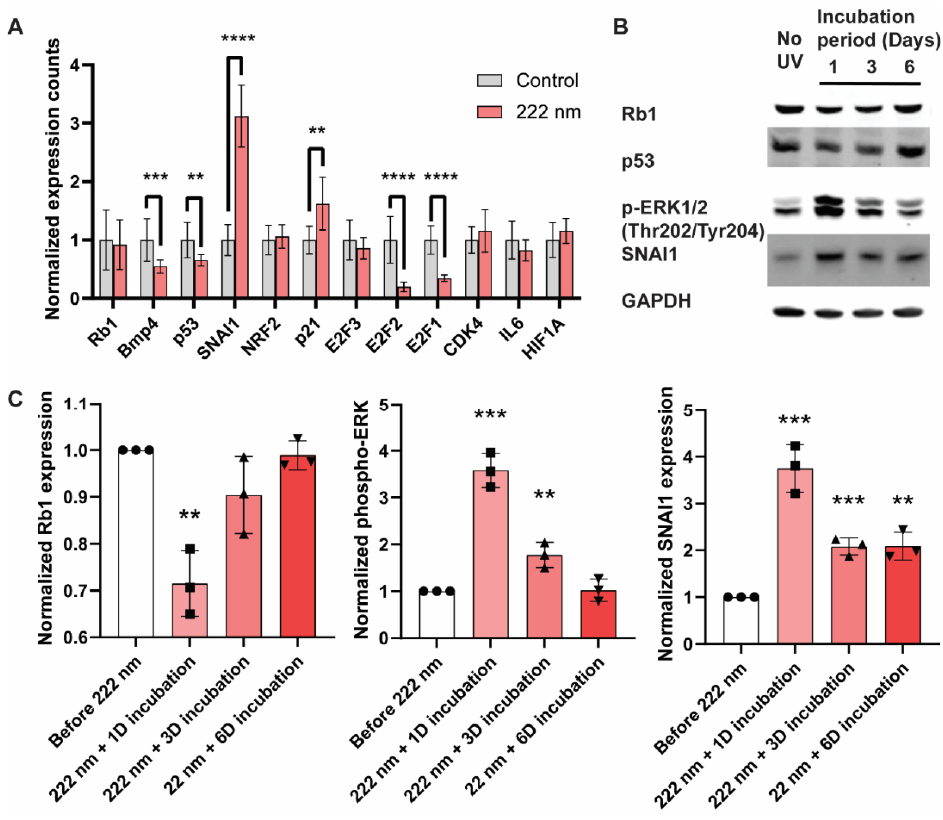
Figure 4. Perturbation of transcription and cellular signaling events was observed in 222 ‐ nanometer ‐ lit cells. ( A ) RT ‐ PCR and Western blot analysis of ARPE ‐ 19 cells after 222 ‐ nanometer far ‐ UVC illumination. ( B ) RT ‐ PCR analysis of selected genes 1 day after 60 min of 222 ‐ nanometer far ‐ UVC illumination. ( C ) Representative Western blots of Rb1, p53, phosphor ‐ ERK (Thr202, Tyr204), SNAI1,